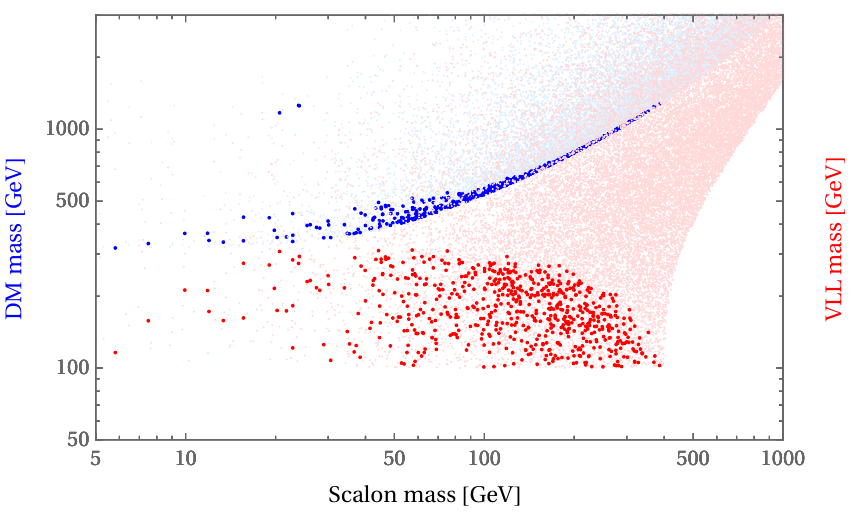
Figure 6 . The scalon mass is shown against the DM mass (blue) and the VLL mass (red) where the correct DM relic density is taken into account. The regions with highlighted colors respect also the constraint from the muon a µ anomaly.